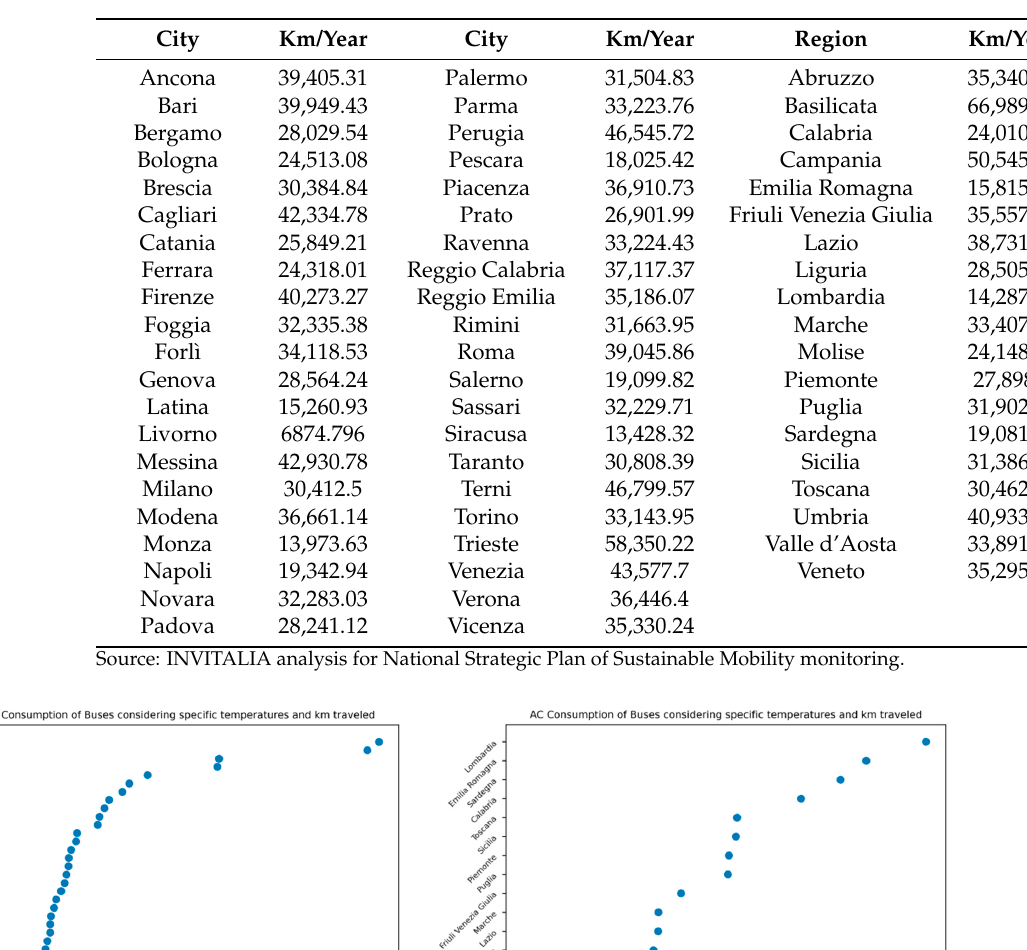
Table 2. 2017 Average annual mileage traveled by a single bus in each territory considered in this work.